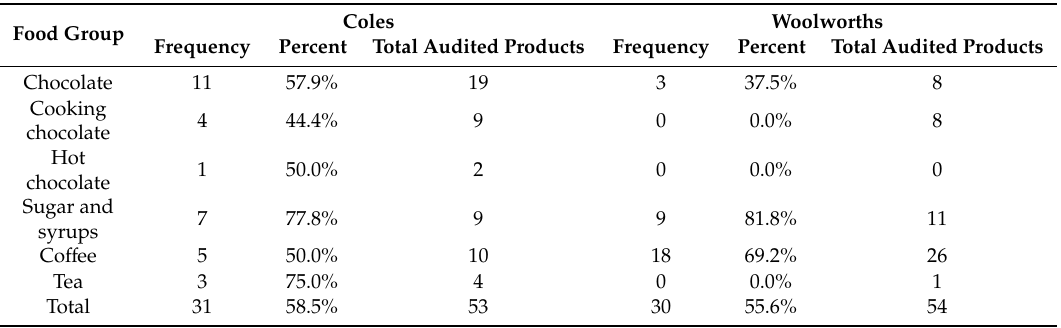
Table 5. Sustainability statements and claims present on Australian supermarket own brand foods: ethical